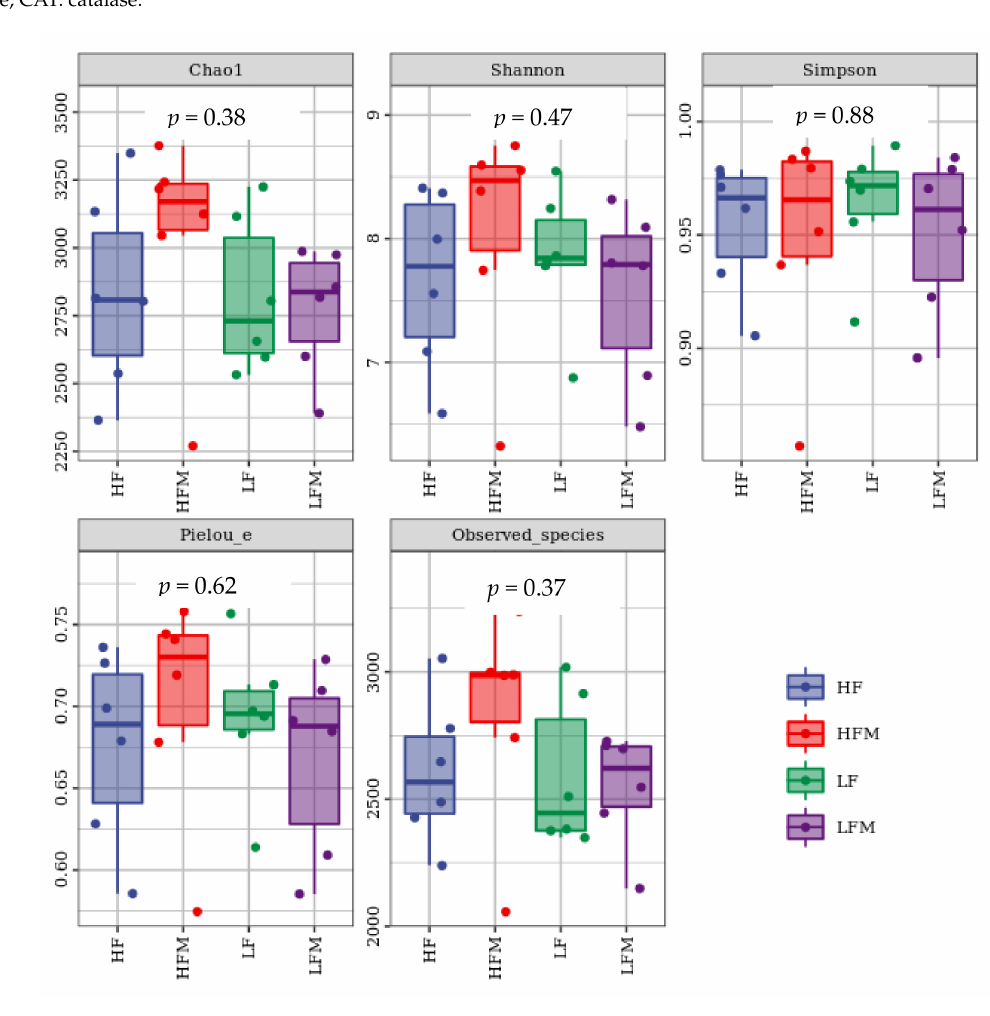
Figure 2. Alpha index box